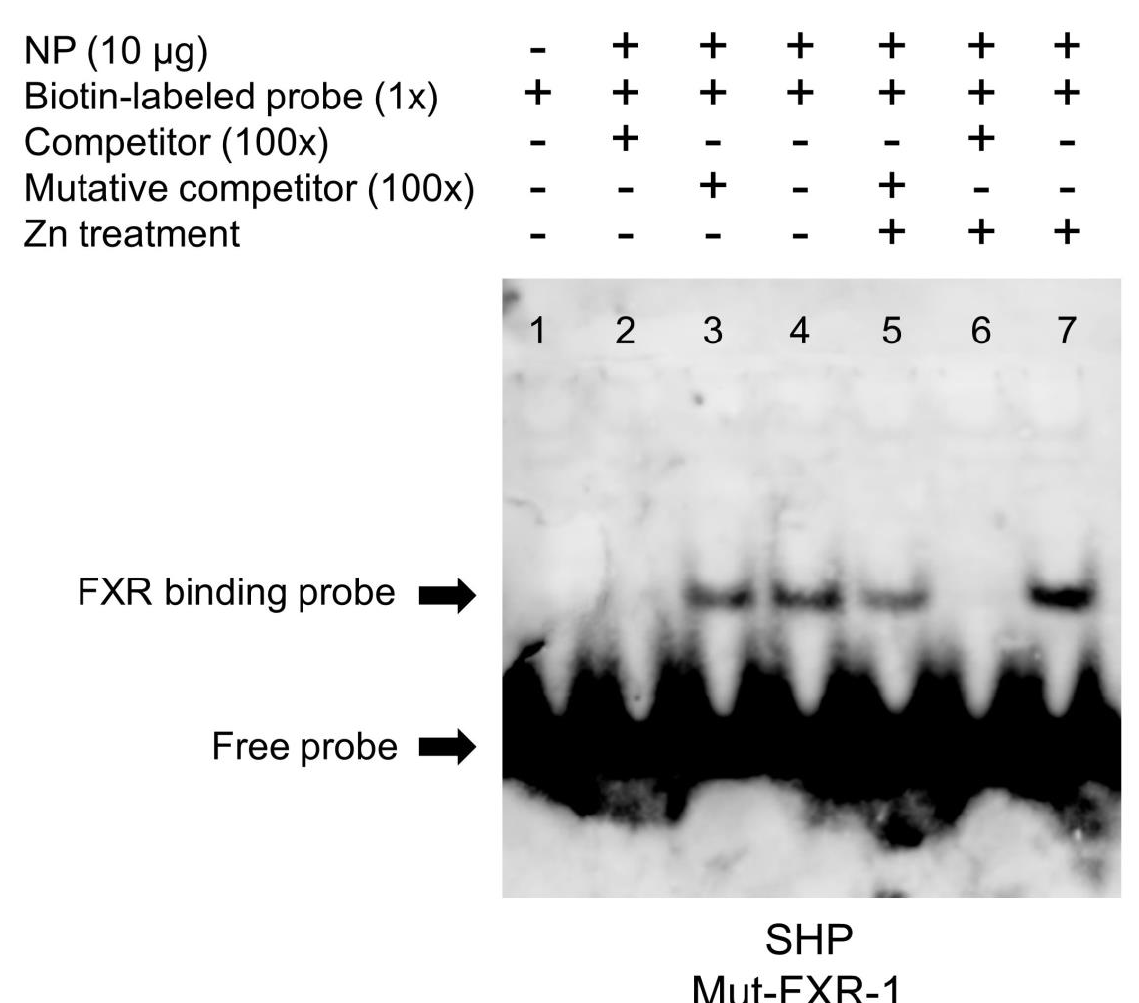
Figure 5. EMSA of predicted FXR binding sequence on yellow catfish SHP promoter (between − 375 bp and − 384 bp). NP, nuclear protein. The numbers 1–7 represent the 7 different